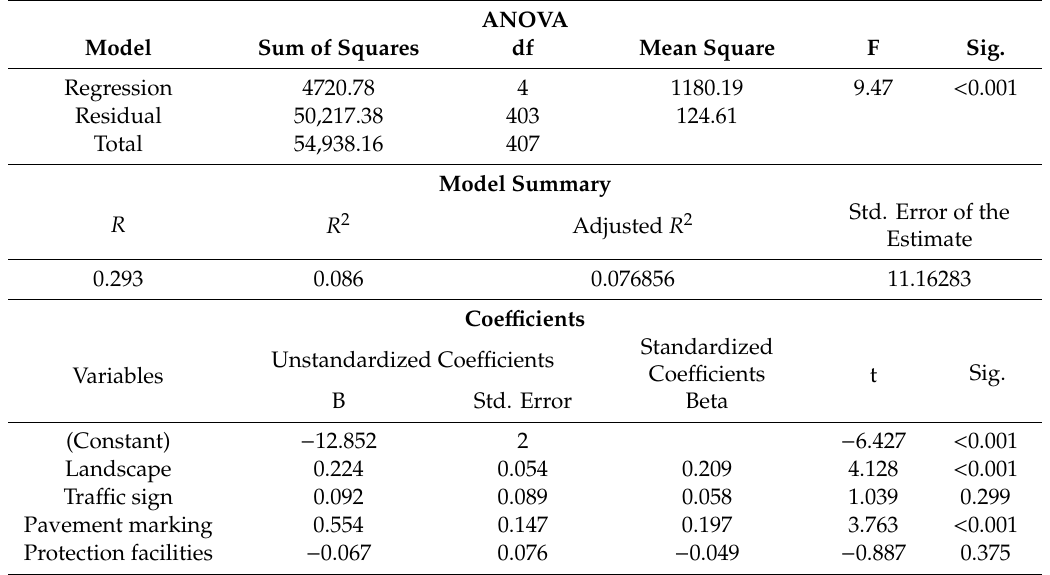
Table 6. Results of multiple linear regression.